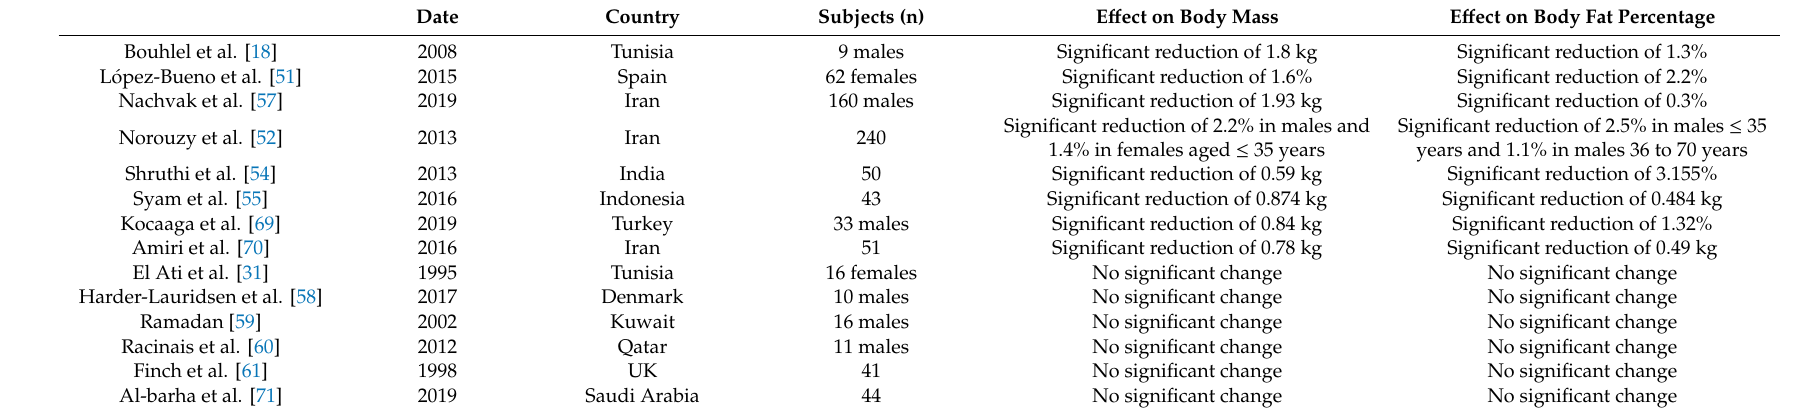
Table 3. E ff ect of Ramadan fasting on body mass and fat percentage of normal weight individuals.